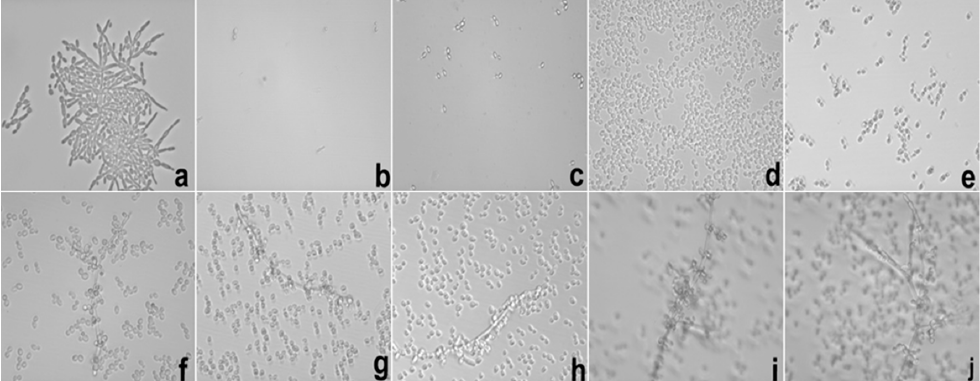
Figure 5. Photomicrography of 12 h of the hyphae inhibition test of Candida albicans ( C. albicans ) realized with E. Legend: ( a ) growth control; ( b ) amphotericin B 16 μ g/mL; ( c – j ) E from 1000 to 7.8 μ g/mL in descending order. E = Extract solution (without incorporation).